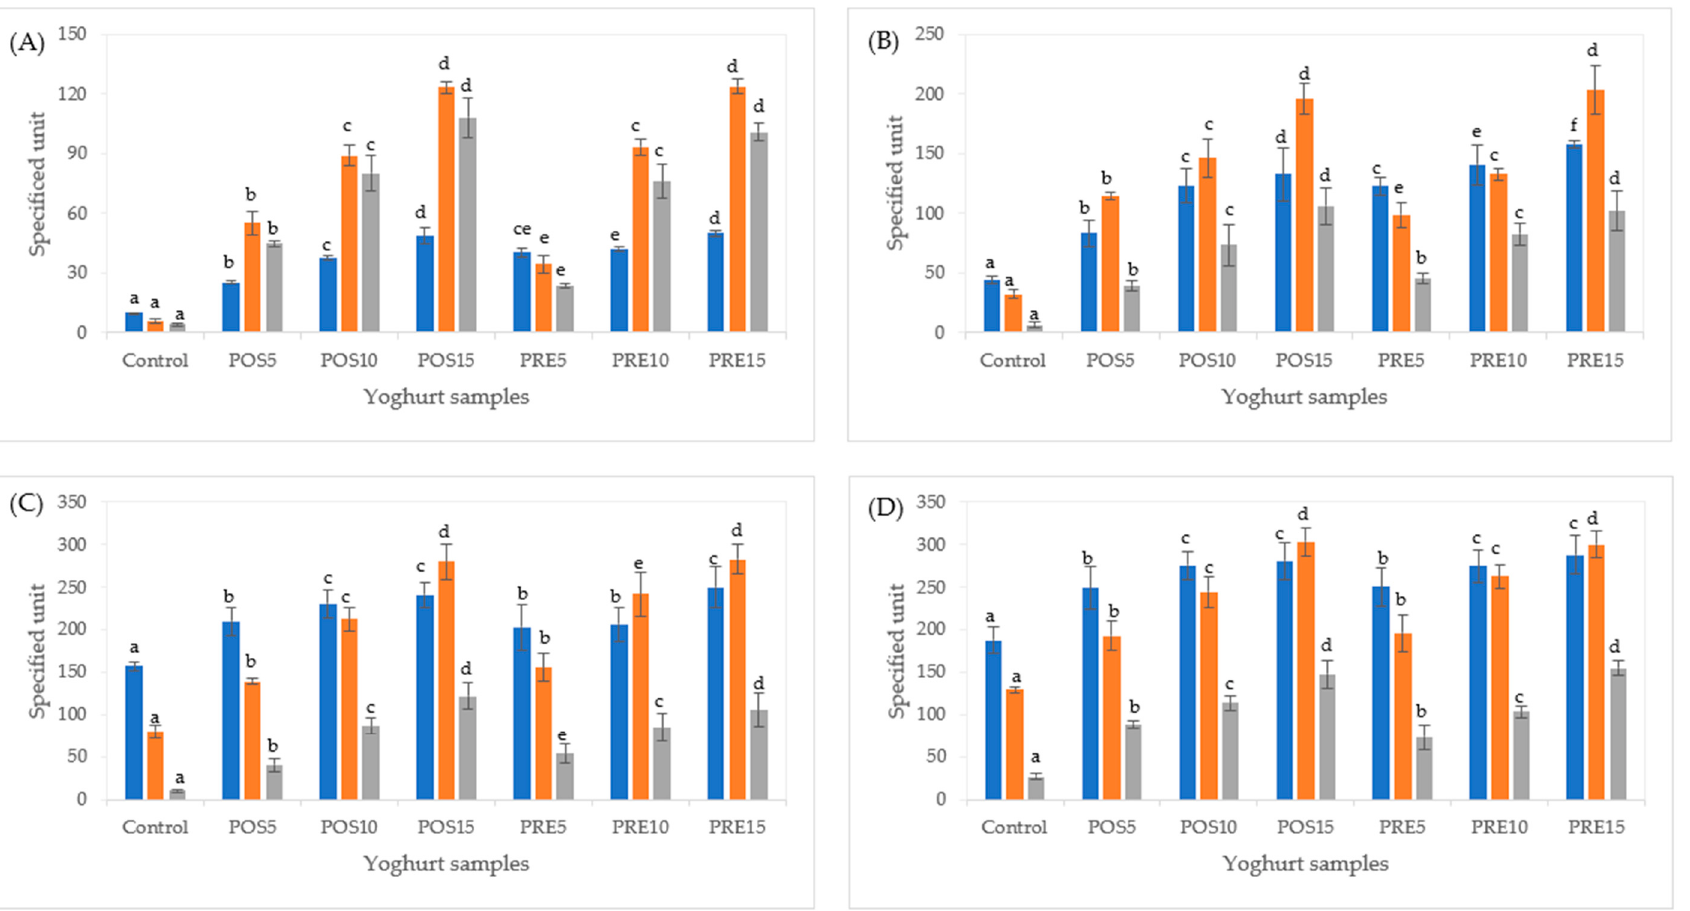
Figure 2. Total phenolic content (TPC) and antioxidant activity (CUPRAC and FRAP assays) of yoghurts fortified with tamarillo powder before digestion ( A ), after oral ( B ), gastric ( C ) and intestinal ( D ) phases of in vitro digestion. TPC ( (cid:4) ) (mg/100 g yoghurt), CUPRAC ( (cid:4) ) (mg TEAC/100 g yoghurt) and FRAP ( (cid:4) ) (mg TEAC/100 g yoghurt). Data are presented as mean and error bar (standard deviation) (n = 3). Different alphabets indicate statistical difference ( p < 0.05) for each assay. POS5, POS10, and POS15: 5%, 10%, and 15% tamarillo powder was added post-fermentation, respectively. PRE5, PRE10, and PRE15: 5%, 10%, and 15% tamarillo powder was added to milk and starter culture prior to fermentation, respectively.